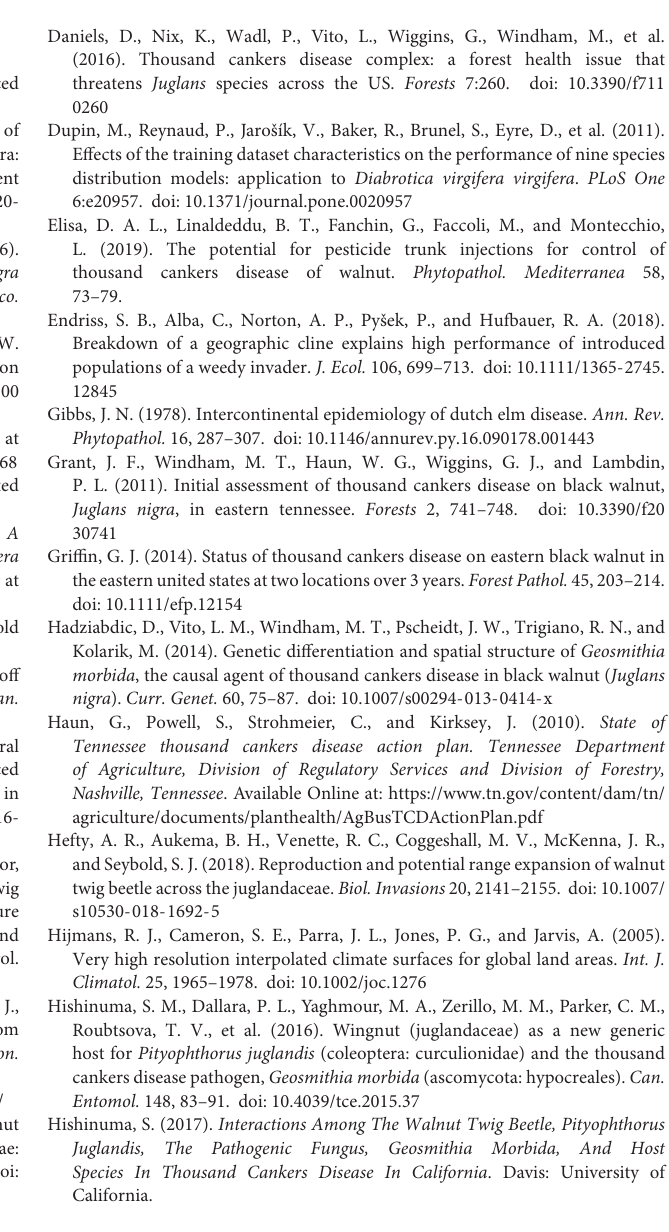
PC3: precipitation in the driest month accounted for 8% of the variation. The legend indicates the climate range, or GPS location, for each family. Each blue dot represents a family. BIO1 = Annual Mean Temperature; BIO2 = Mean Diurnal Range (Mean of monthly (max temp – min temp)); BIO3 = Isothermality (BIO2/BIO7) ( × 100); BIO4 = Temperature Seasonality (standard deviation × 100); BIO5 = Max Temperature of Warmest Month; BIO6 = Min Temperature of Coldest Month; BIO7 = Temperature Annual Range (BIO5-BIO6); BIO8 = Mean Temperature of Wettest Quarter; BIO9 = Mean Temperature of Driest Quarter; BIO10 = Mean Temperature of Warmest Quarter; BIO11 = Mean Temperature of Coldest Quarter; BIO12 = Annual Precipitation; BIO13 = Precipitation of Wettest Month; BIO14 = Precipitation of Driest Month; BIO15 = Precipitation Seasonality (Coefficient of Variation); BIO16 = Precipitation of Wettest Quarter; BIO17 = Precipitation of Driest Quarter; BIO18 = Precipitation of Warmest Quarter; BIO19 = Precipitation of Coldest